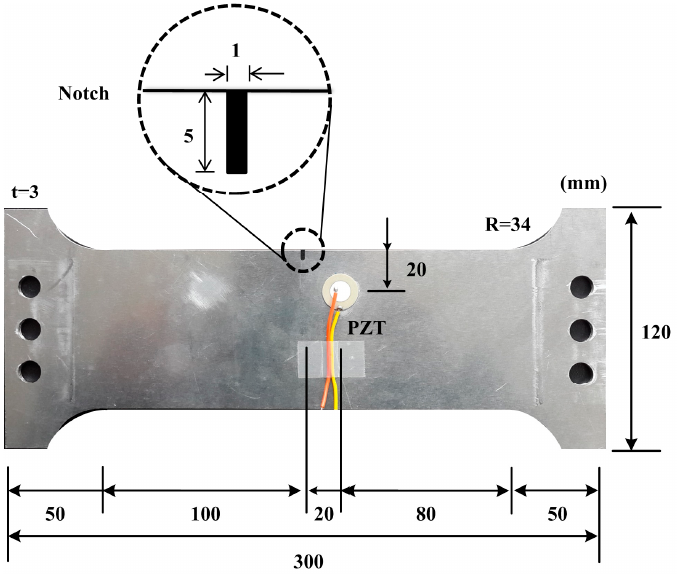
Figure 6. Target structure with the self-sensing nonlinear ultrasonic system installed. Sensors 2018 , 17 , x FOR PEER REVIEW